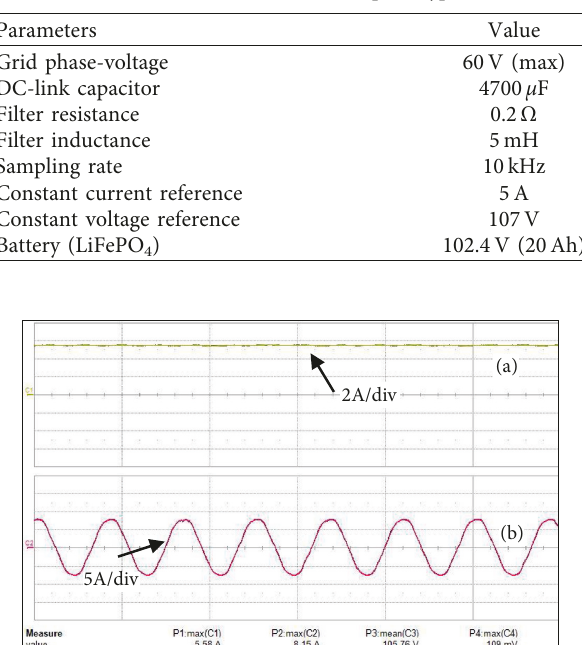
Figure 14: A simplified experimental setup circuit. Table 2: Parameters of the prototype.